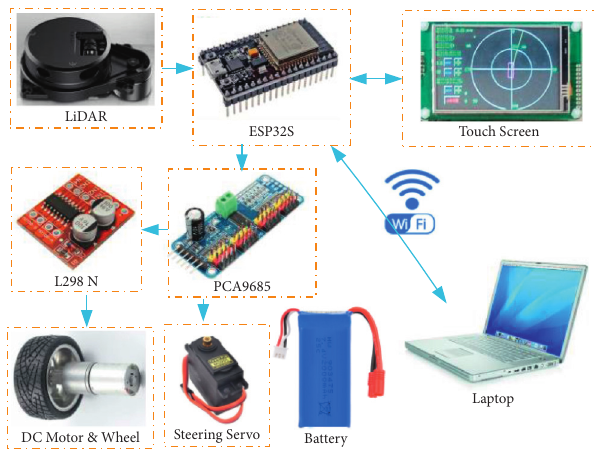
Figure 3: Hardware structure of the five-axle all-wheel-steering wheeled